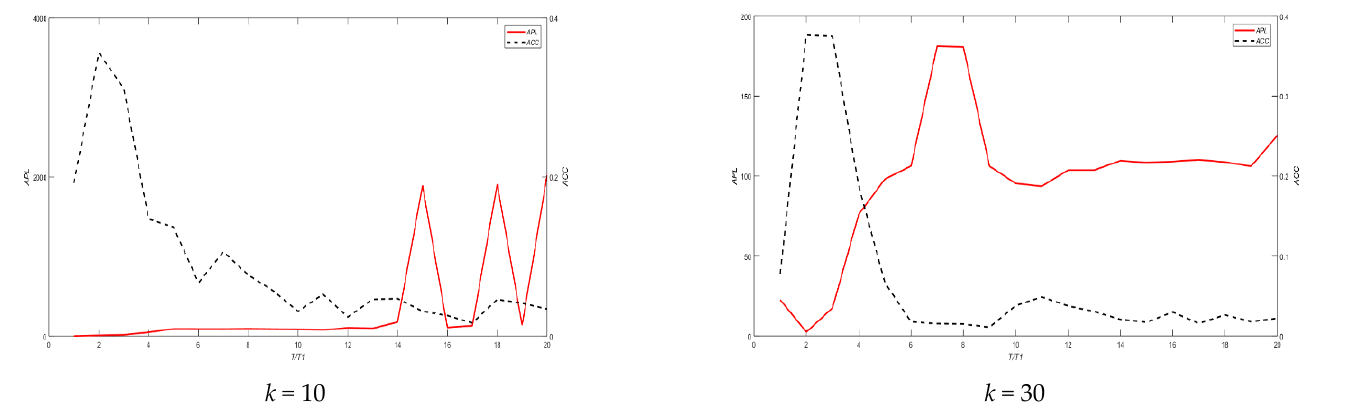
Figure 9. Effect of changes in the number of knowledge types k on APL and ACC.